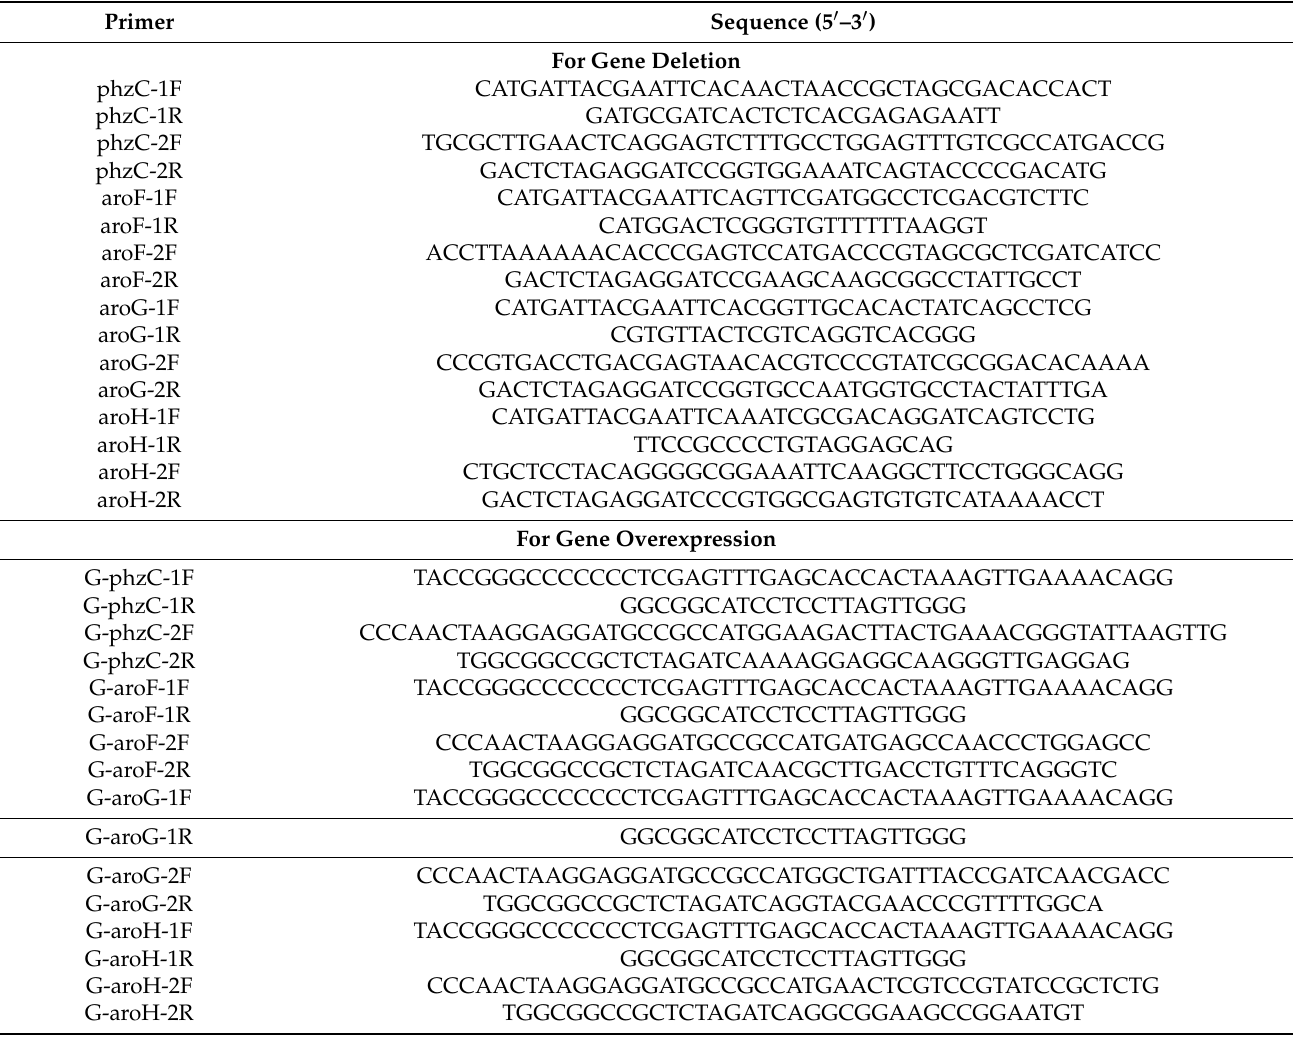
Table 2. Main primers designed and used in this